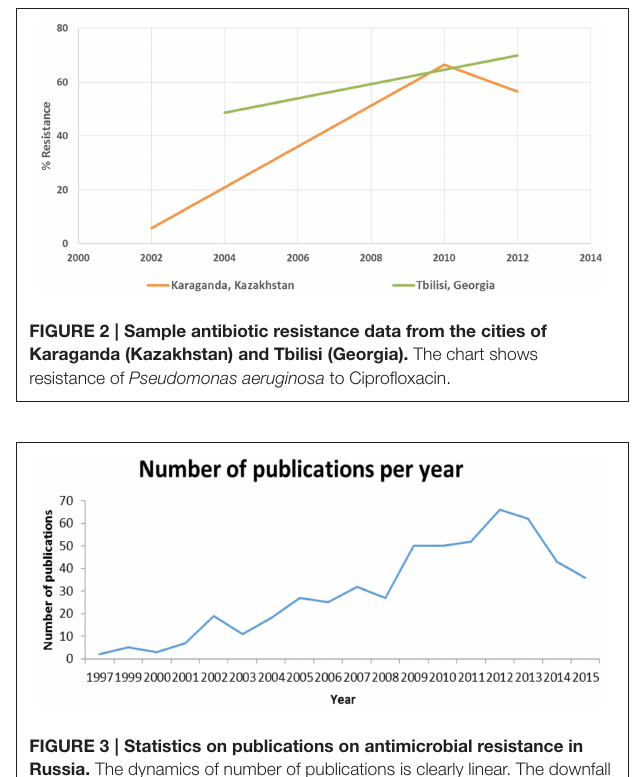
FIGURE 3 | Statistics on publications on antimicrobial resistance in Russia. The dynamics of number of publications is clearly linear. The